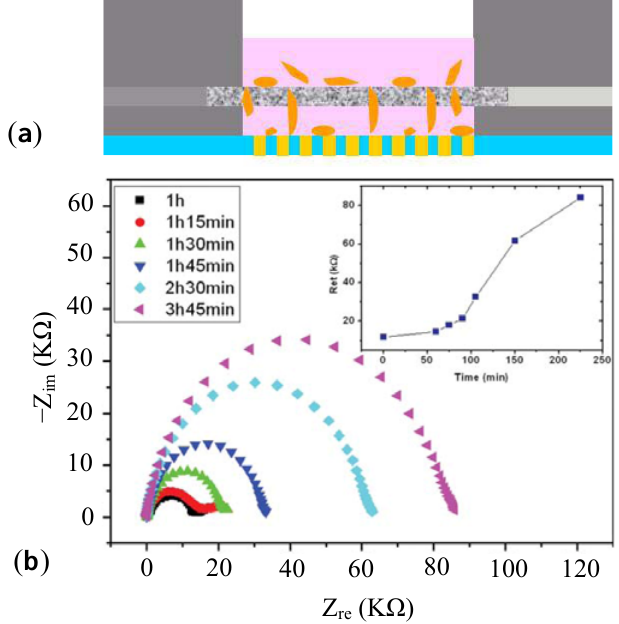
Figure 26. ( a ) Autotranswell cell chip for migration assay; ( b ) Real time monitoring of cell migration. Inset shows the time course of